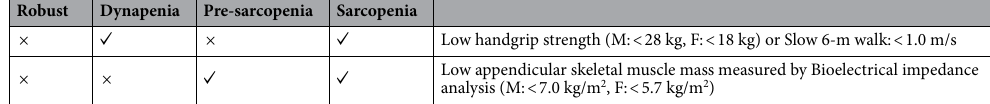
Table 2. Criteria for inclusion in the robust, dynapenia, presarcopenia, and sarcopenia groups. According to Asian Working Group for Sarcopenia: 2019 Consensus Update on Sarcopenia Diagnosis and Treatment.